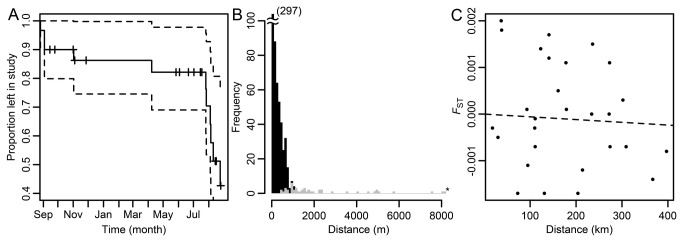
Survival and residency, spillover, and gene flow of lobsters in Skagerrak.(A) Survival and residency of 30 lobsters within a MPA over one year. Crosses indicate censored individuals, where the depth sensor has emitted nonsensical depth readings and the individual is out of the study. (B) Movement distances by lobsters tagged within reserves and recovered by recreational and commercial fishers outside reserves (grey bars), and recaptured by the authors within the reserves during the annual research trapping (black bars). The bars are stacked and movement distances are classified into increments of 100 m. *Note that four lobsters were recovered by fishers beyond 8200 m (11.5, 15, 15, and 21 km away from reserve centres). (C) Regression between pairwise FST and geographic distance between samples.